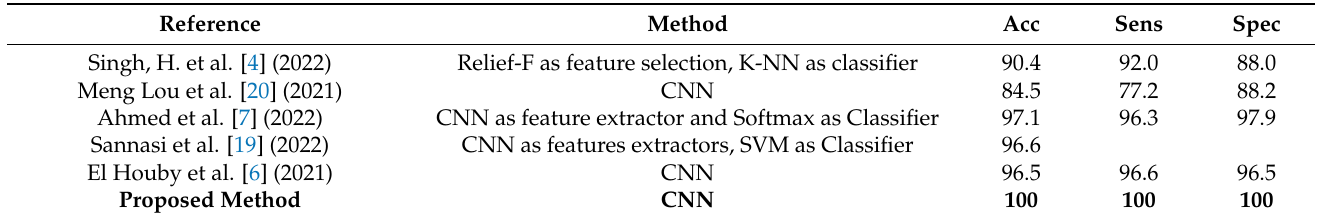
Table 7. Performance comparison between proposed method and state-of-the-art on INbreast